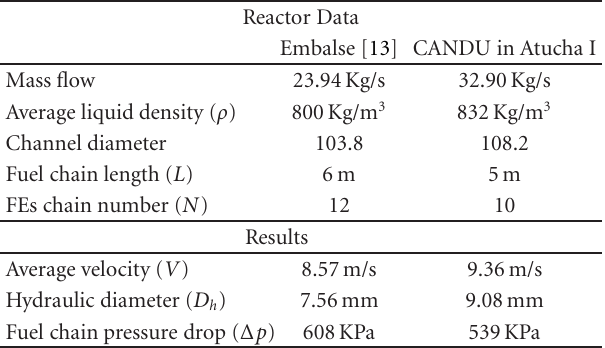
Table 2: Hydraulic parameters of the hottest (design case) fuel channel.